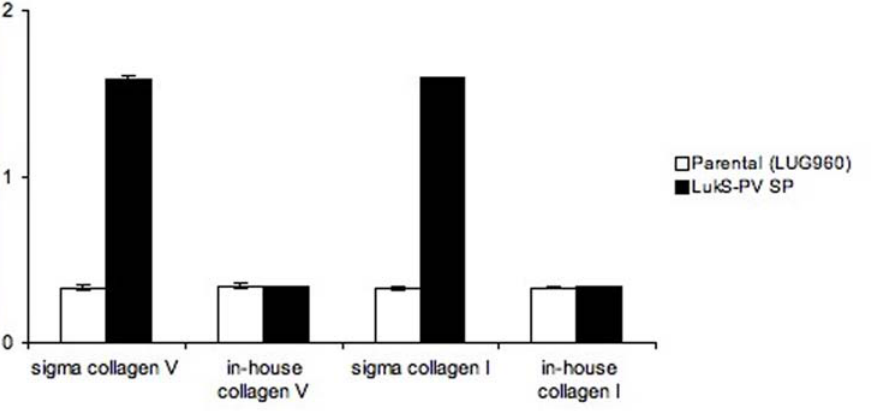
Figure 5. Binding capacity of isogenic strains to collagens V and I from distinct sources. Isogenic strains examined for their binding capacity (Y-axis, absorbance reading at 540 nm) to collagens I and V (Sigma) versus in-house preparation of collagens I and V coated on 96-well plates, at concentrations of 5 m g/mL. Parental (LUG960) indicates the genetic background in which the genetic modifications were made; LukS-PV SP, parental carrying a plasmid encoding the LukS-PV signal peptide. The vertical lines indicate the standard deviations.